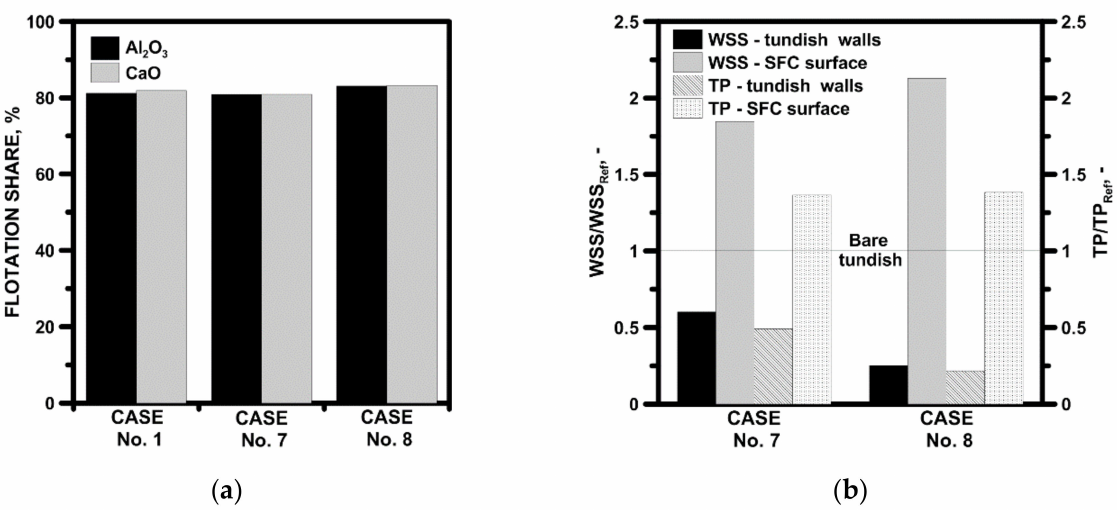
Figure 16. Behavior of non-metallic inclusions and potential of tundish lining wear: ( a ) flotation of non-metallic inclusions, ( b ) wall shear stress and total pressure in tundish and SFC